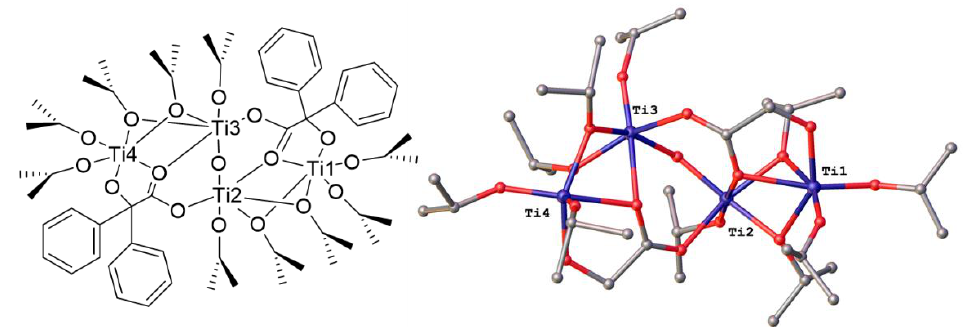
Figure 3. Asymmetric unit of 3 . For clarity, atoms are drawn as spheres of arbitrary radius, minor disorder is not shown, and hydrogen atoms are not shown. Selected bond lengths (Å) and bond angles ( o ): Ti(1)-O(1) 2.136(8), Ti(1)-O(3) 1.888(9), Ti(1)-O(7) 1.832(9), Ti(1)-O(8) 1.697(10), Ti(1)-O(9) 2.277(9),